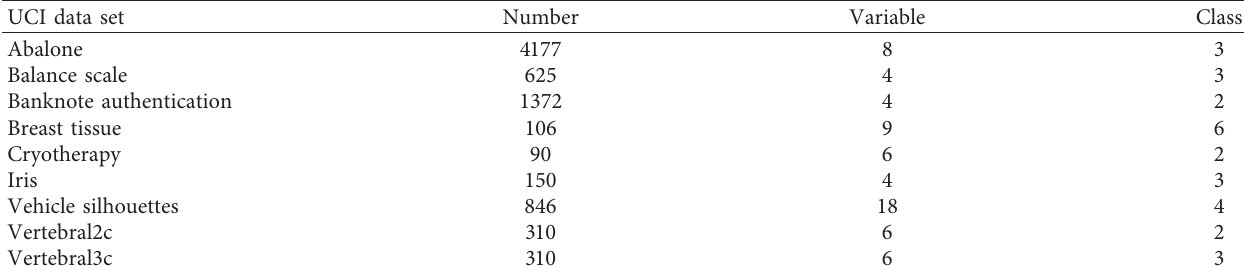
Table 1: Information of different data sets.